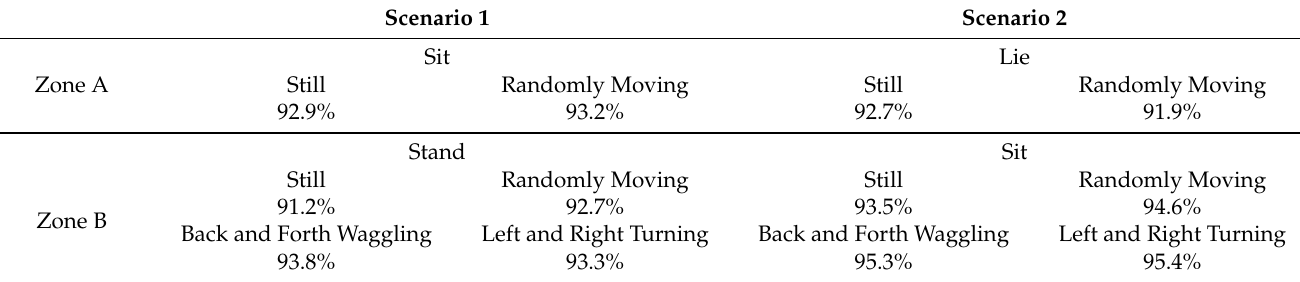
Figure 9. A generated heartbeat signal from A-FuseNet. Table 7. Vital sign monitoring accuracies in 12 conditions.